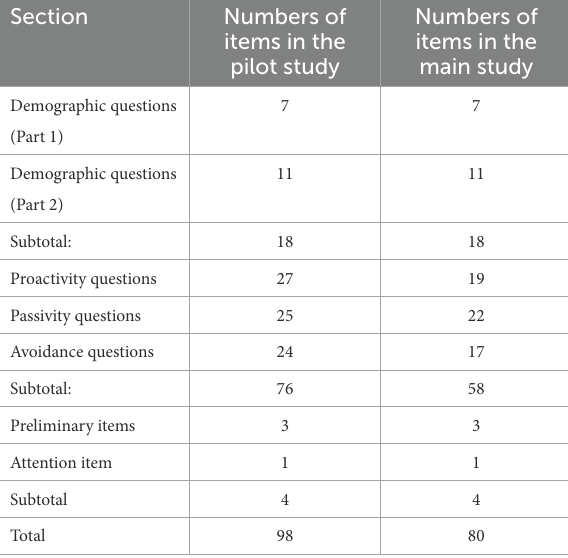
TABLE 1 Number of items in pilot study and main